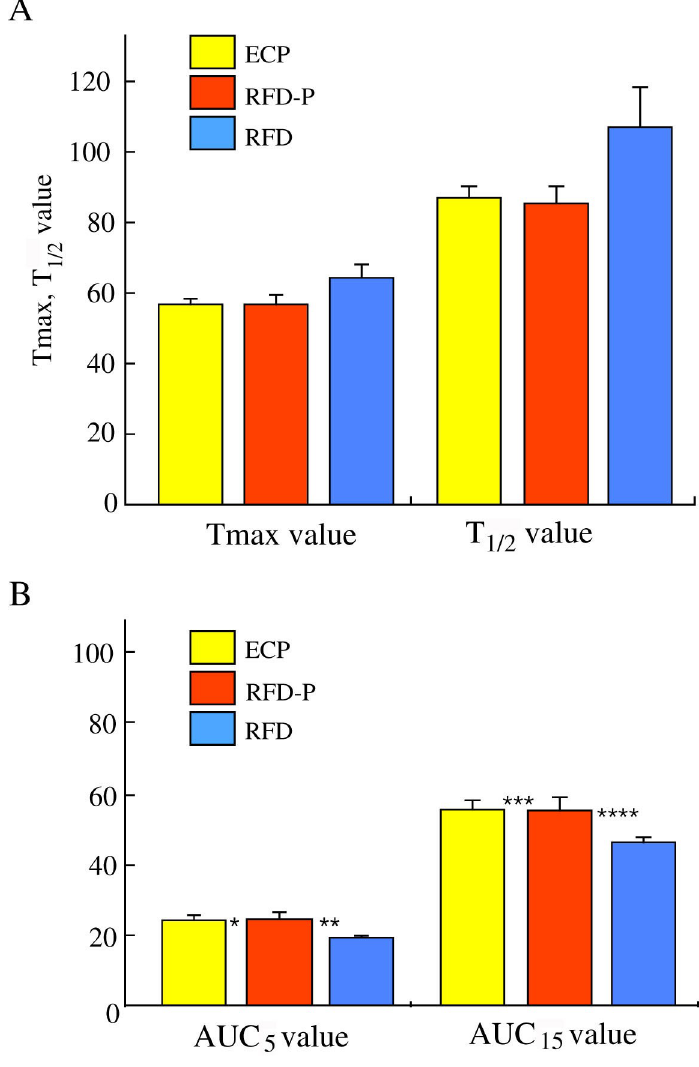
Fig 3. Comparison of gastric motility among ECP patients, RFD-P patients and RFD patients. A . There were no significant differences in Tmax and T 1/2 values among early chronic pancreatitis (ECP), anti-acid therapy-resistant FD patients with pancreatic enzyme abnormalities (RFD-P) and anti-acid therapy-resistant FD (RFD) patients. B . AUC 5 values (24.7 ± 1.57 and 24.6 ± 2.00, respectively) in ECP and RFD-P patients were significantly higher compared to that (19.2 ± 0.81) in RFD patients. AUC 15 values (55.8 ± 2.73 and 55.4 ± 3.94, respectively) in ECP and RFD-P patients were also significantly higher compared to that (46.3 ± 1.57) in RFD patients. � P = 0.003, vs RFD patients, �� P = 0.004, vs RFD patients, ��� P = 0.004, vs RFD patients, ���� P = 0.001, vs RFD patients. 1.91 ± 0.21; p = 0.53) in the severity of duodenal inflammatory cells infiltration between ECP